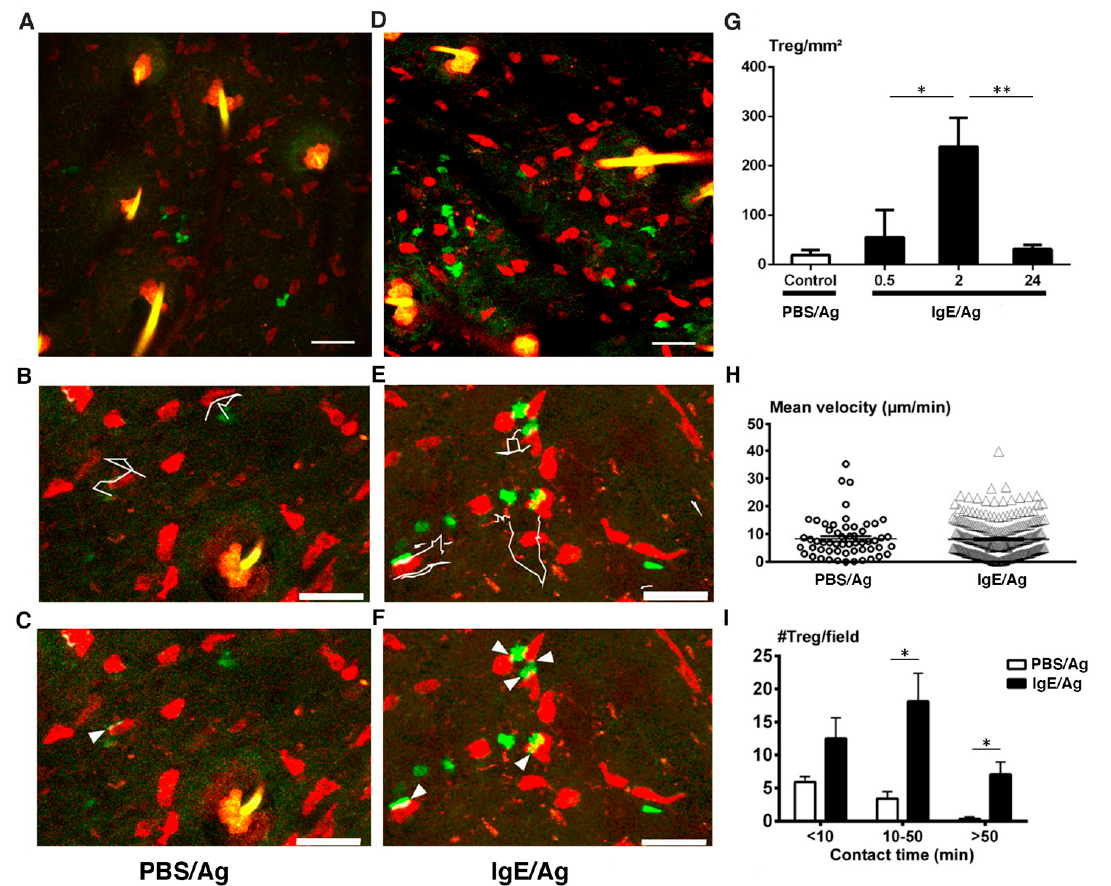
Figure 4. Mast cells interact with Tregs after IgE-mediated degranulation. Photomicrographs showing the distribution ( A , D ), in situ mobility ( B , E ) and contact profile ( C , F ) of Foxp3-eGFP + Tregs as analyzed by intravital confocal microscopy of control PBS-sensitized ( A – C ) or IgE-sensitized ( D – F ) ear skin of RMB-Foxp3-eGFP mice 2 to 3 h after challenge with Ag (DNP-HSA). ( G ) Tregs were enumerated in control PBS- or IgE-sensitized ear skin of RMB-Foxp3-eGFP mice after challenge with